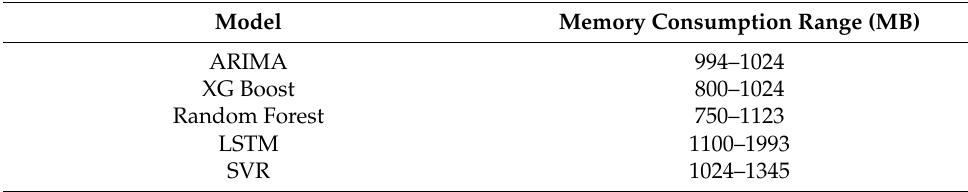
Table A1. Memory consumption by ML/DL Models during training and